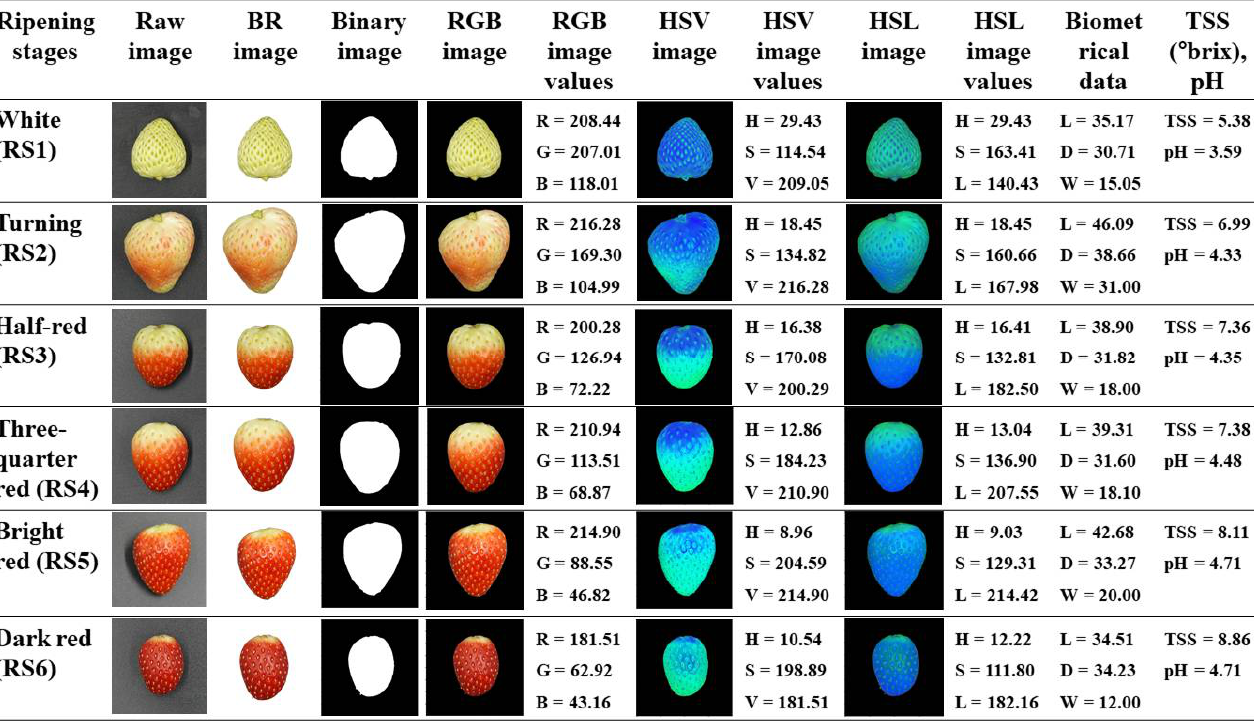
Figure 2. Images of strawberries with background removal (BR), binary, RGB, HSV and HSL colour spaces in six ripening stages. Biometrical data (Length (L in mm), diameter (D in mm) and weight (W in g)) and TSS (°brix) with pH are shown in the two right columns, respectively.